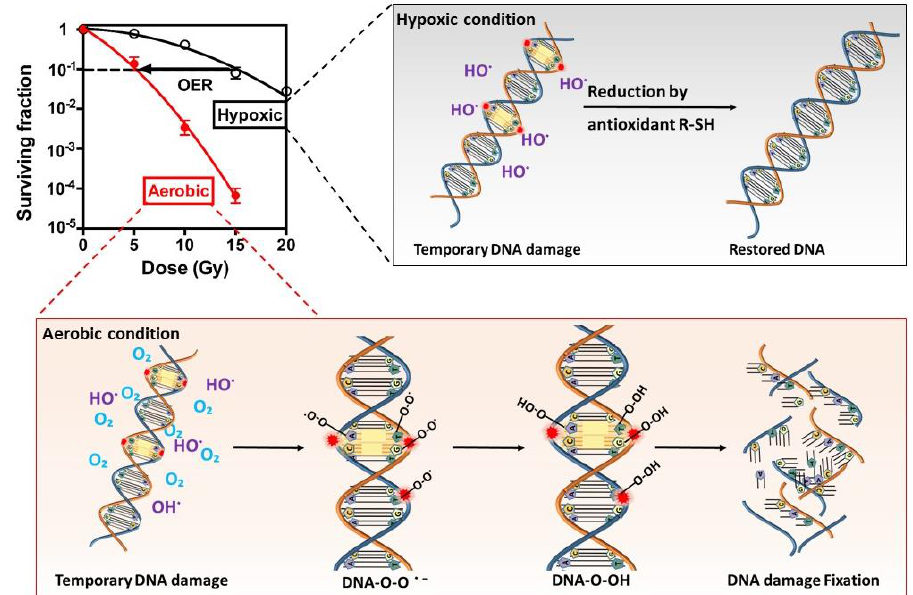
Figure 2. The oxygen fixation hypothesis. Under aerobic condition, radiation induced DNA radicals are able to react with oxygen, resulting in permanent DNA damage and strand breaks. Under hypoxic condition, the lack of oxygen enables the DNA radicals to be reduced to the original form that hampers the generation of strand breaks. Hypoxia-induced radioresistance can be estimated by survival curves. Briefly, the oxygen enhancement ratio (OER) or hypoxic radioresistance can be represented by a ratio, which is calculated by dividing doses administered under hypoxic to aerobic conditions needed to achieve a same survival fractions.